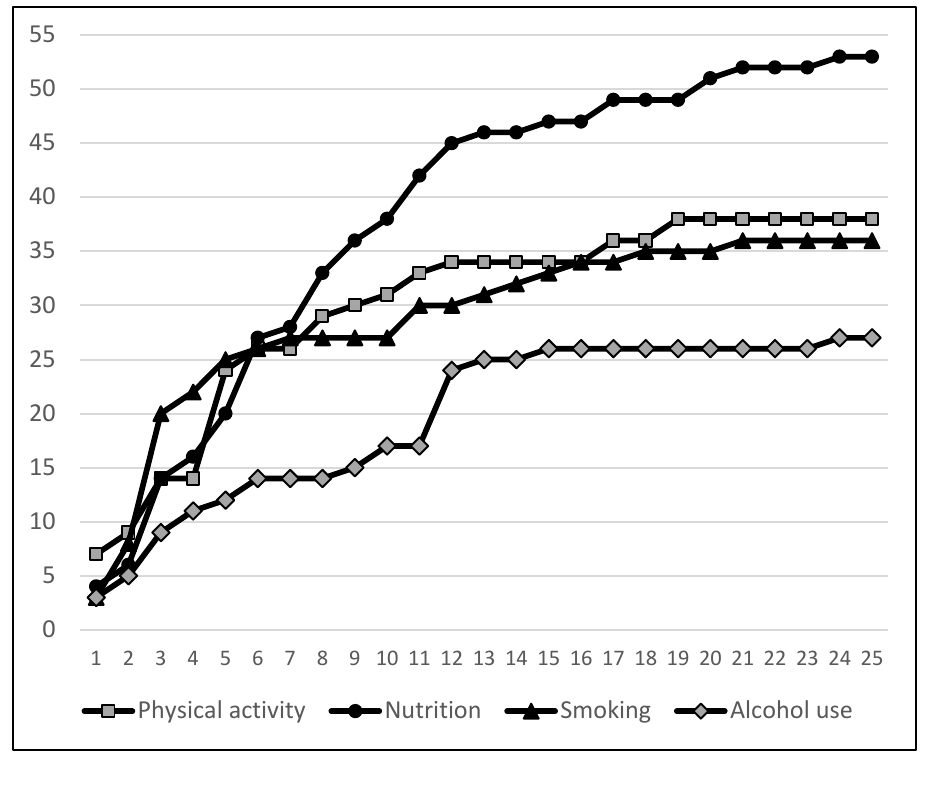
Figure 1. Total number of barriers and facilitators (y axis) mentioned during the 25 interviews (x axis) per health behavior.